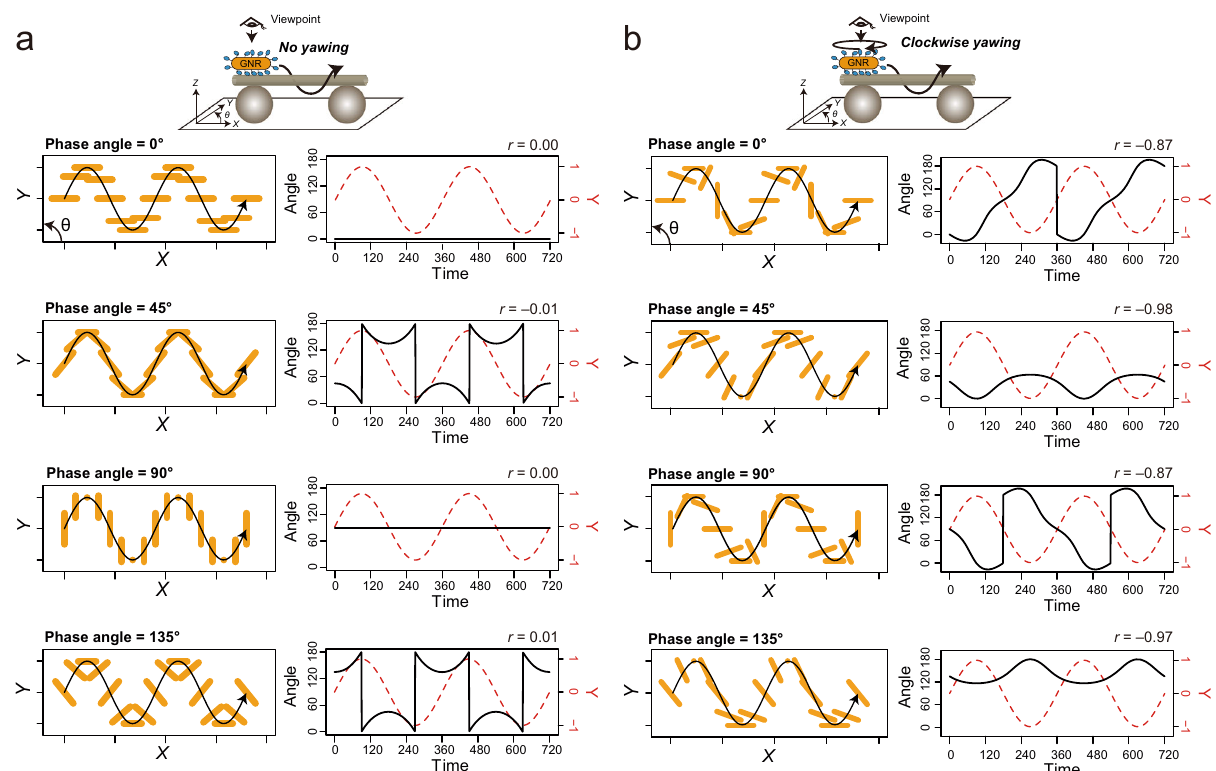
Fig. 4 Interpretation of the observed polarization rotations and translational movement of the kinesin-coated gold nanorods (GNRs). a , b Montage of the projection images of a GNR (orange bar) in the X-Y plane, obtained by a model of a motor-coated GNR with no yawing ( a ) or 180° clockwise yawing during one period of helical motion ( b ). Time trajectories of the Y -displacement ( Y = − 1 to 1) and angle ( θ = 0 to 180°) of a motor-coated GNR with different initial phase angles ( φ = 0°, 45°, 90°, and 135°). The value of r is Pearson ’ s correlation coef fi cients between the Y -displacement and the angle. Trajectories of a motor-coated GNR in the case of counterclockwise yawing are shown in Supplementary Fig. 6. See also Supplementary Movies 2, 4, and